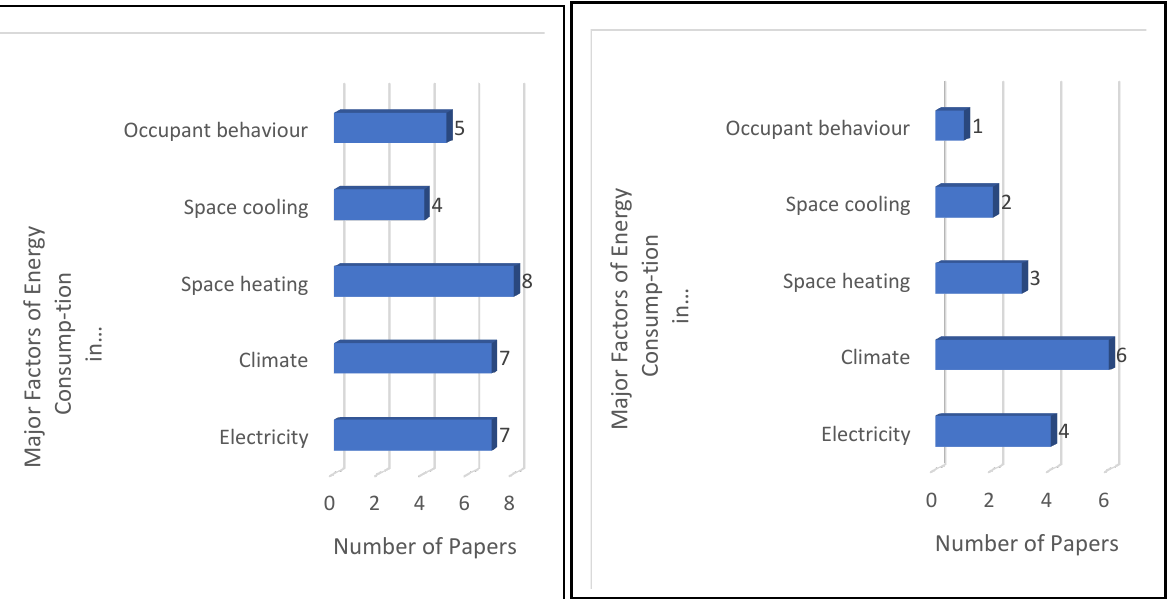
Figure 8. Major factors of energy consumption in residential and public buildings.